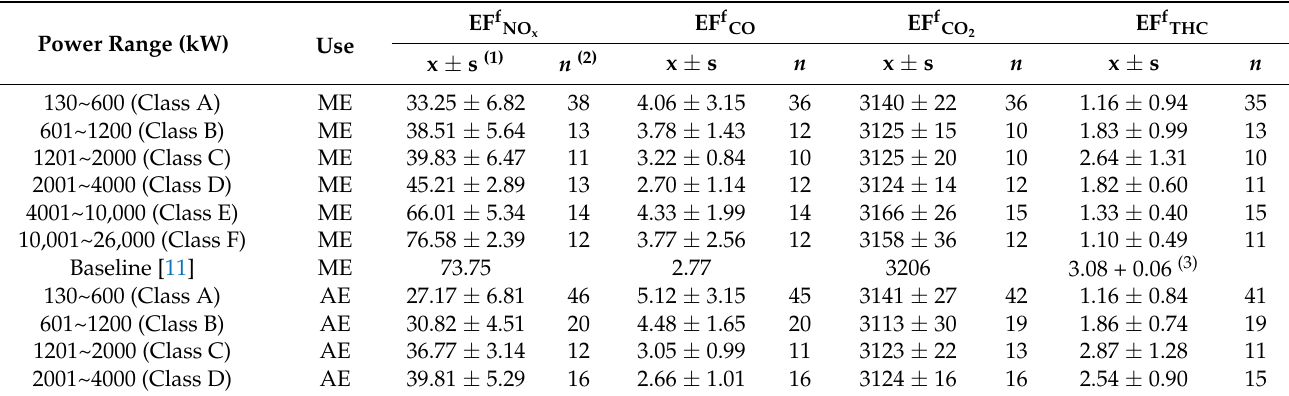
Table 2. Fuel-based emission factor